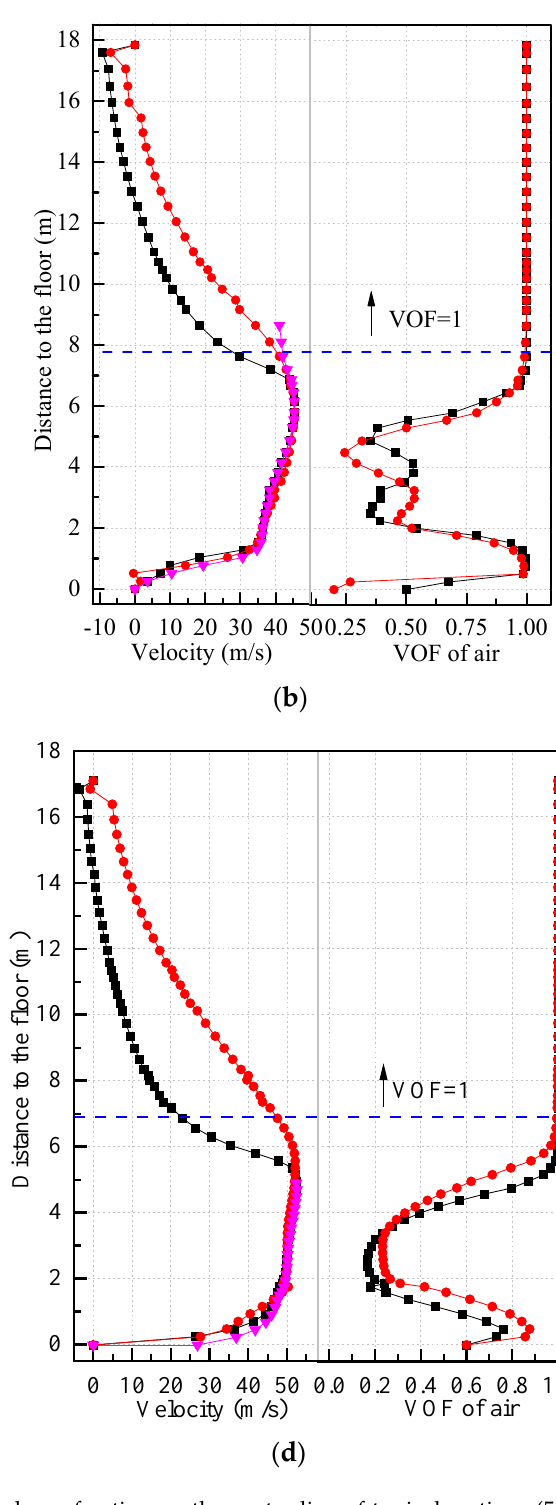
Figure 5. Water velocity and air volume fraction on the center line of typical sections (50% gate opening ratio) ( a ) downstream the gate, section marked 0 + 773.1 m; ( b ) downstream the aerator no. 2, section marked 1 + 141.90 m; ( c ) downstream the aerator no. 3, section marked 1 + 221.87 m; ( d ) downstream the aerator no. 4, section marked 1 + 360.52 m.